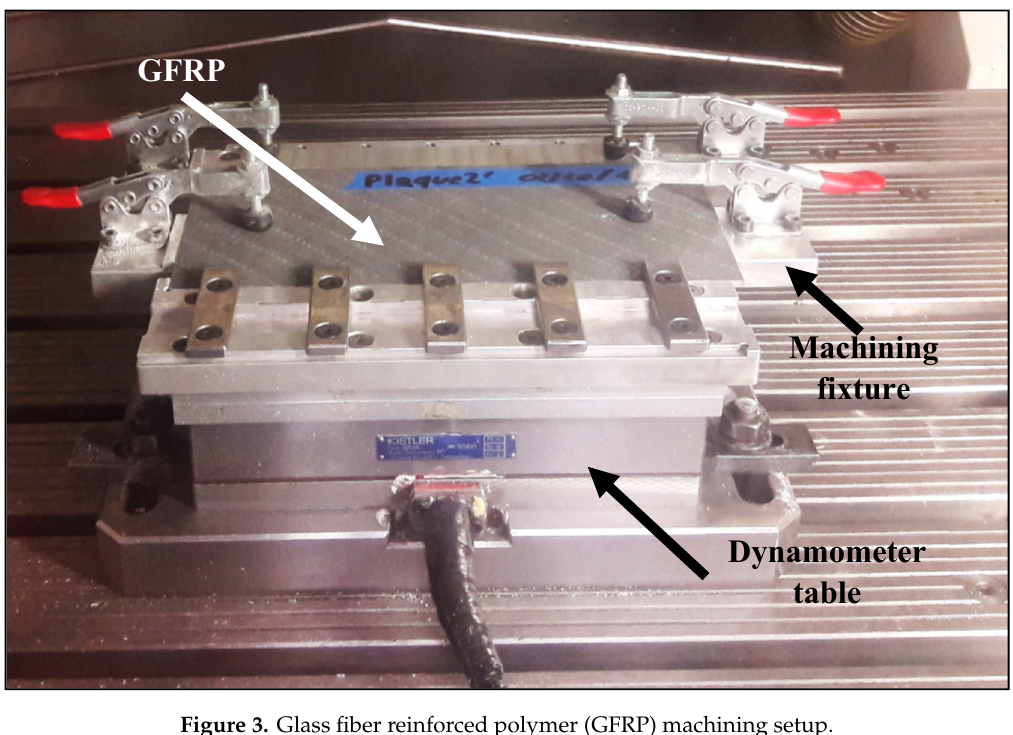
Figure 3. Glass fiber reinforced polymer (GFRP) machining setup.